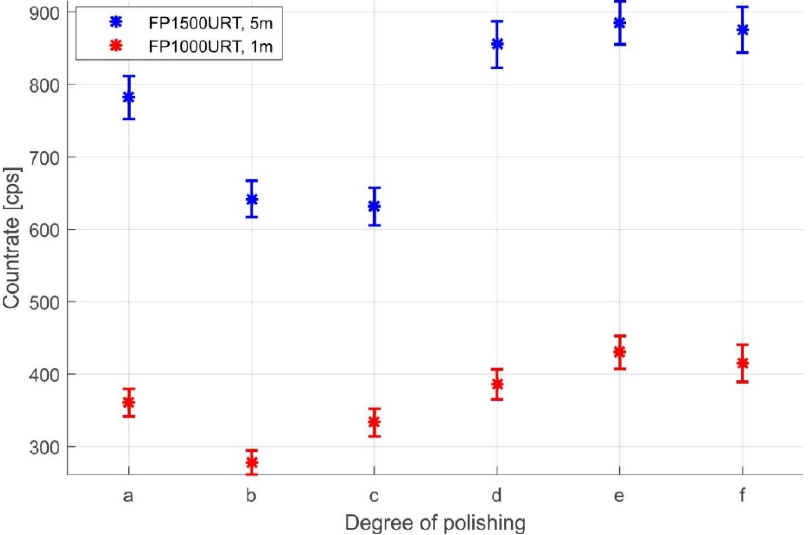
Figure 6. The amount of coupled, transferred, and emitted scintillation radiation depends on the roughness levels for the FP1500URT and FP1000URT. The SPC detector detected the scintillation radiation.